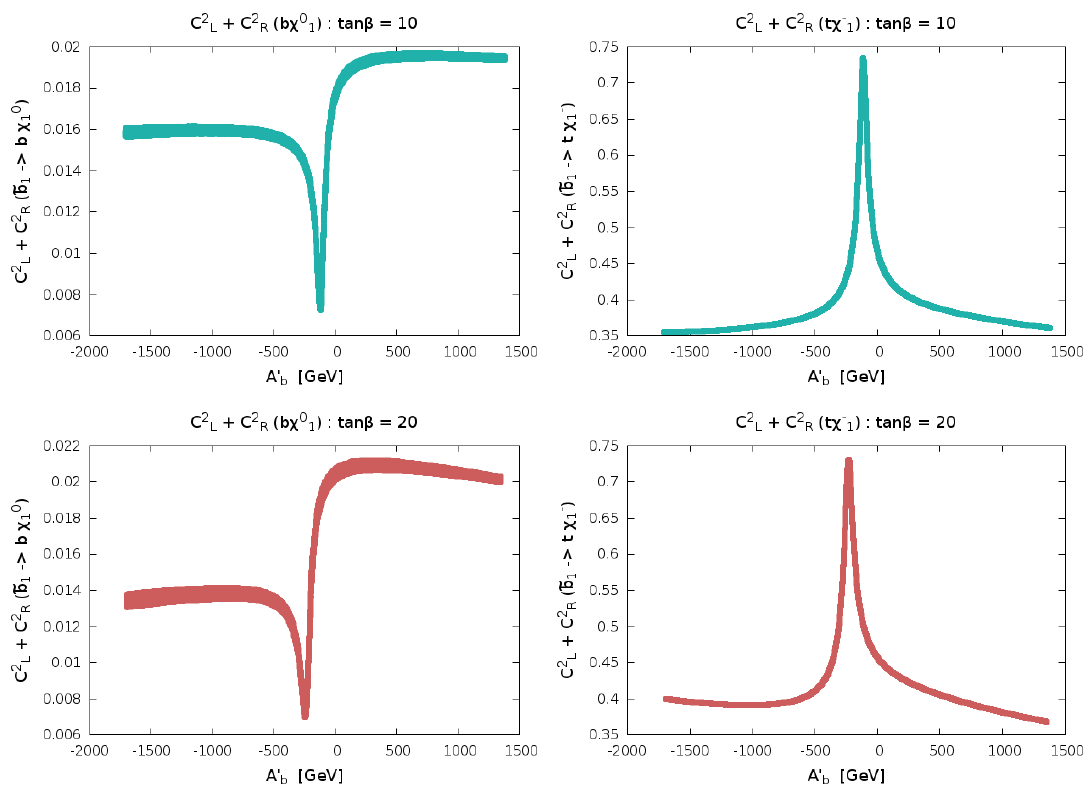
Figure 4 . Same as in (cid:12)gure 3 but for a scenario having a gaugino (bino)-like LSP with (cid:22) = 900 GeV while the (cid:12)xed input range of M 1 used is 100 GeV tan (cid:12) values used here is 20 (bottom panel) instead of 40 used in (cid:12)gure 3 (see text for